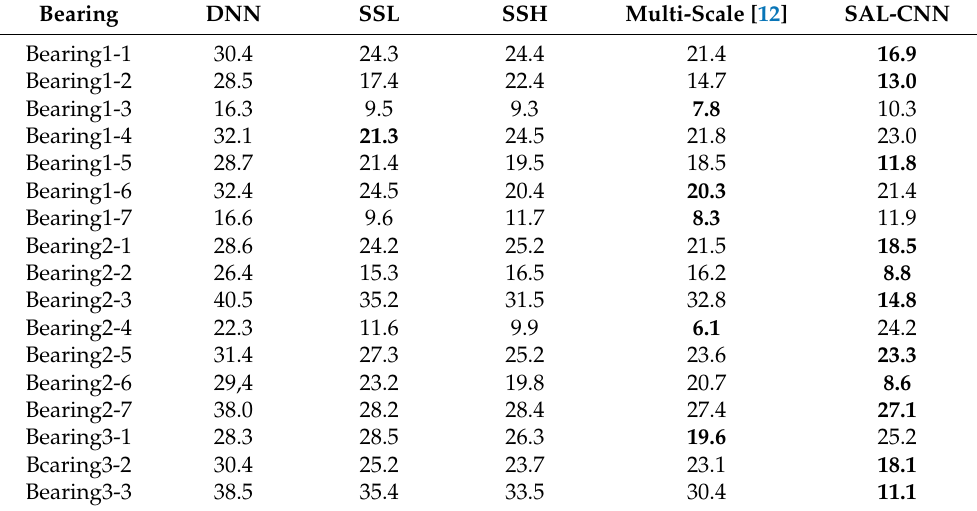
Table 3. Comparison of life prediction results based on MAE index. Lower MAE means better